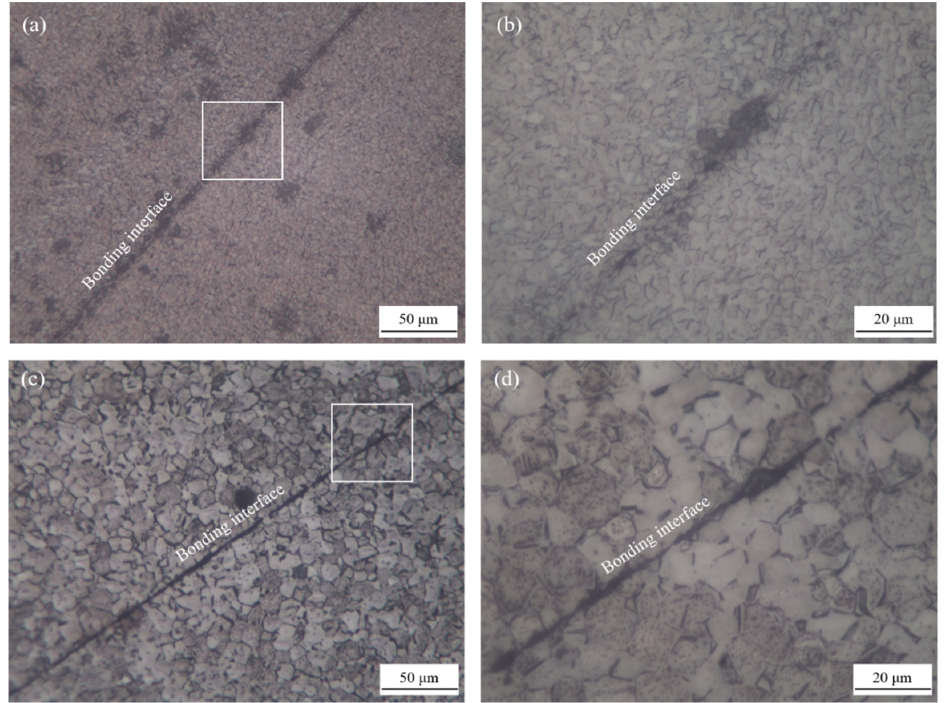
Figure 6. ( a ) Grain structure at the bonding interface for the initial materials; ( b ) high magnification of the square insets in Figure 6a. ( c ) Grain morphology of the heat-treated specimen at the bonding interface; ( d ) high magnification of to the square insets in Figure 6c.